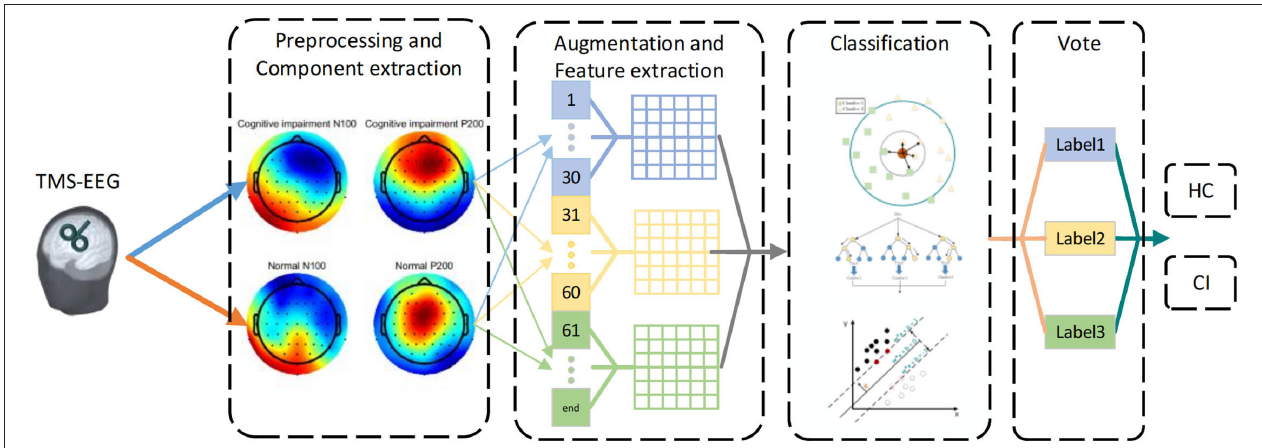
FIGURE 1 | The framework of CI detection based on TEPs. First, the N100 and P200 components of TEPs were selected after removing artifacts. Then, all trials were divided into three segments. Subsequently, seven features were extracted from different segments and regions of interest (ROIs) respectively. Finally, machine learning was used to classify features, and voted on each segment to get the predicted